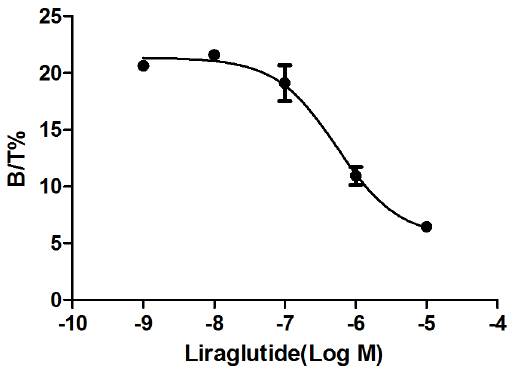
Figure 2. Competitive binding curve. IC 50 , the half-inhibition concentration of liraglutide, was 542.4 6 187.5 nmol/L. Error bars represent 1 SD of the